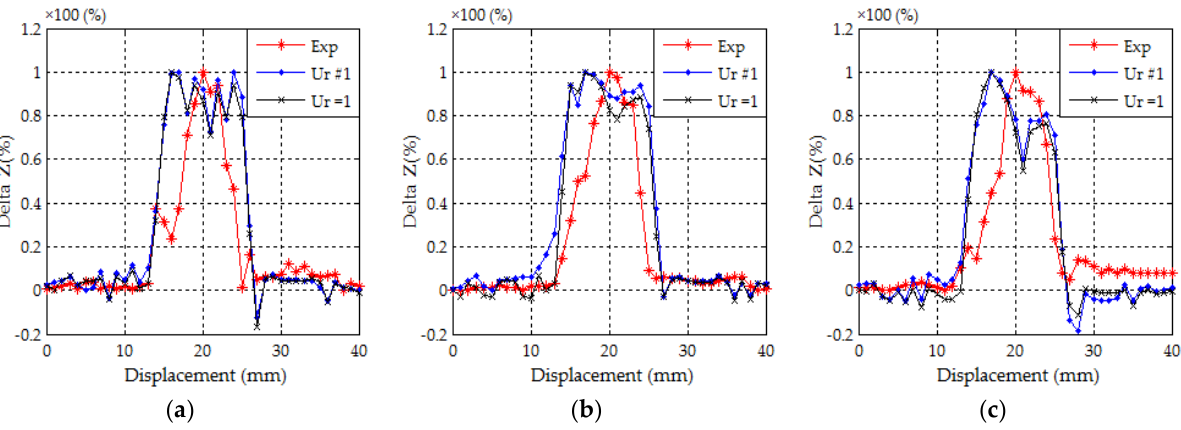
Figure 13. Impedance variation in (%) at 300 kHz with ( a ) depth = 0.3 mm, ( b ) depth = 0.5 mm, and ( c ) depth = 1 mm.